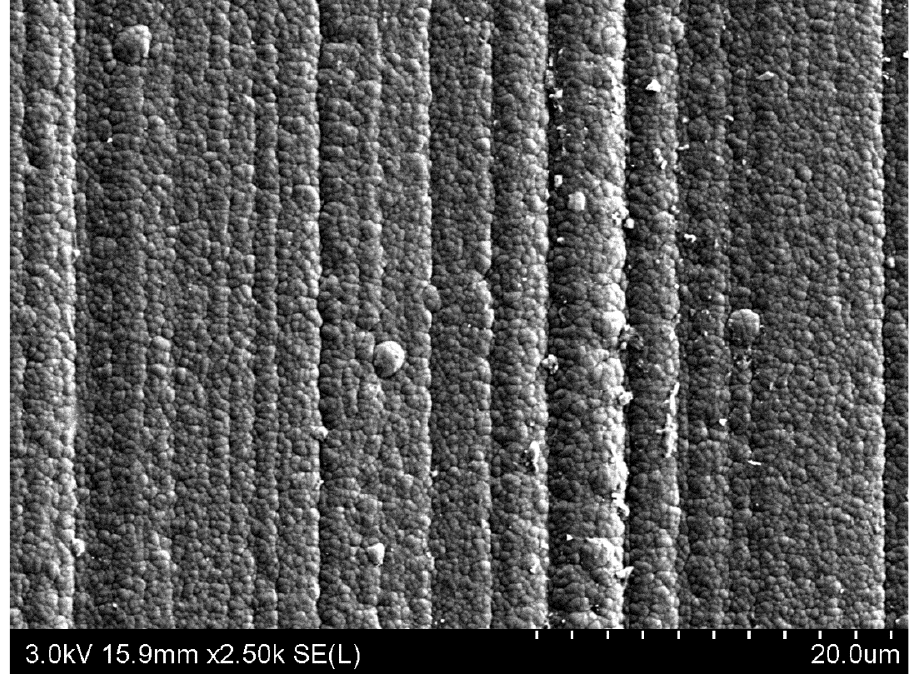
Figure 6. SEM image of the “a-C:N” coating (Hitachi SU-70 scanning electron microscope). The tool wear indicator was determined separately for each of the drill bit